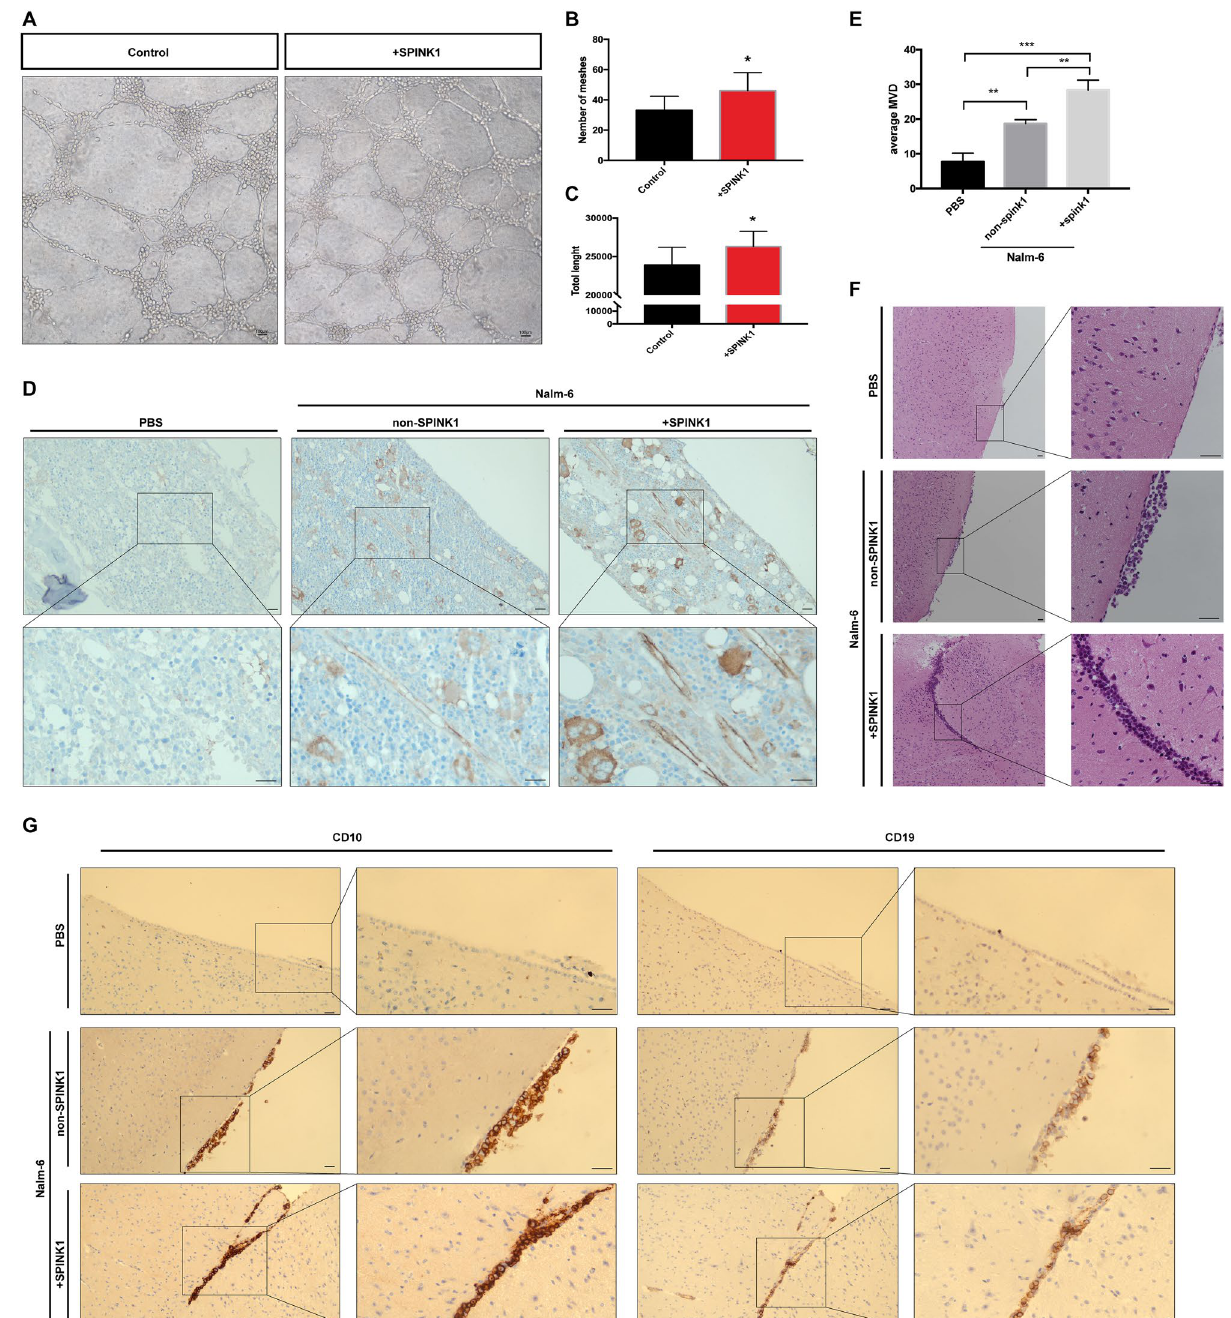
Figure 3. SPINK1 treatment stimulated in vitro and in vivo angiogenesis and brain infiltration. ( A ) Phase contrast micrographs demonstrating that SPINK1 induces endothelial network formation on Matrigel. Compared with the control group without SPINK1 treatment, adding 50 ng/ml SPINK1 to HUVECs enhanced formation of capillary-like structures (a marked raise in number of meshes and the total length of the cables). ( B ) Measurement of the number of meshes using ImageJ software. ( C ) Measurement of the total length of the cables using ImageJ software. ( D ) and ( E ) Average MVD calculation containing SPINK1 stimulates angiogenesis in B-ALL-NOD/SCID mice; tibial sections with immunohistochemical staining (SP two-step method) and CD34 as a marker of vascular lineage. PBS : Negative control, the normal NOD/SCID mouse with tail vein injection of PBS. Nalm-6 : B-ALL-NOD/SCID model mice, the NOD/SCID mouse with tail vein injection of Nalm-6 cells (5 × 10 6 ). Non-spink1 : tail vein injection without SPINK1. + SPINK1 : tail vein injection with 100 µg SPINK1. F: HE staining to be performed to observe the degree of tumor cell infiltration. G: The immunohistochemical staining to be performed to confirm the HE results. The NALM-6 NOD/SCID model mice treated with SPINK1 showed a deeper degree of brain tumor cell infiltration than that without the SPINK1 treatment. * p ≤ 0.05, ** p ≤ 0.01, *** p ≤ 0.001, **** p ≤ 0.0001; unpaired